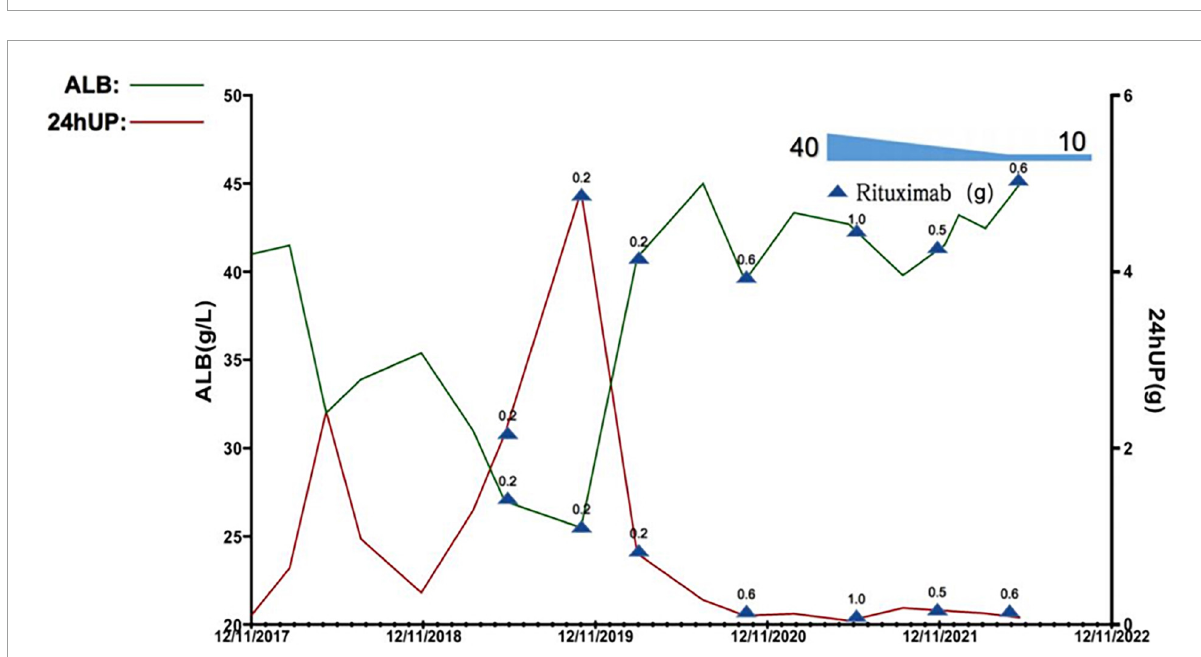
FIGURE3 Quantification in levels of plasma albumin (alb) and 24-h urinary protein excretion (24hUP) of this patient during the observational period. 0.2, 0.5, 0.6, and 1.0 denote the dose of rituximab used at this timepoint (g,